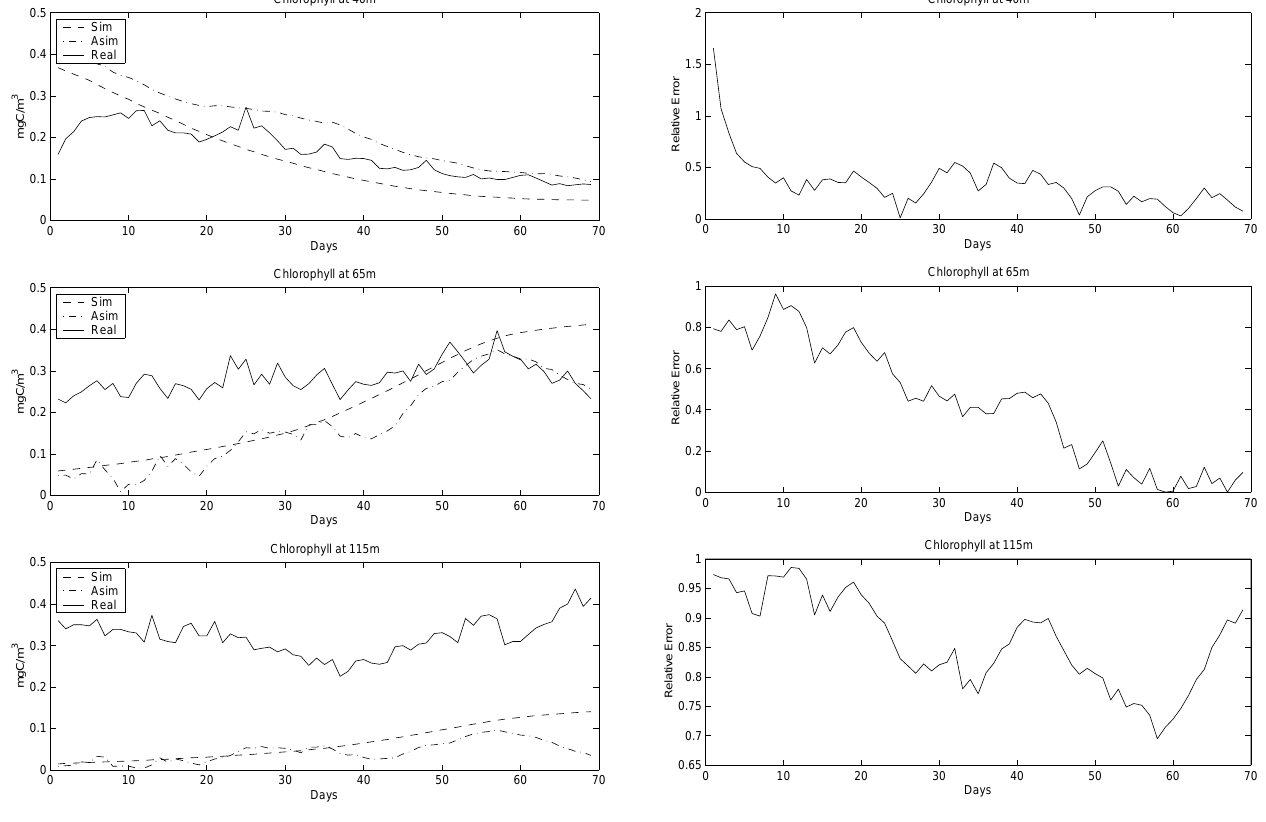
Fig. 6. Evolution in time of the relative error of the SEEK filter for chl-a from the experiment with real